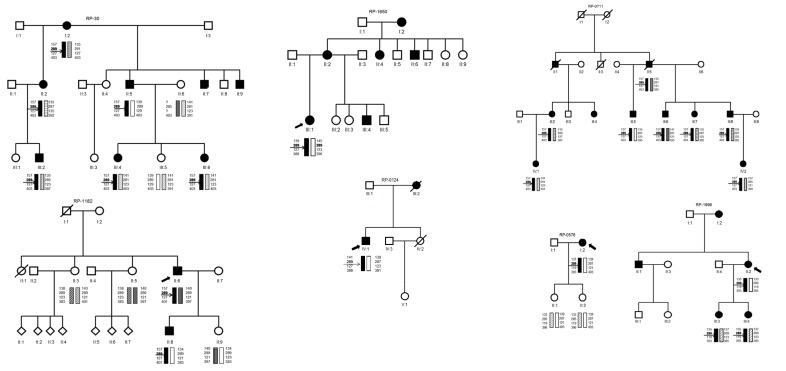
Pedigrees and Haplotype analysis of adRP families with p.Gly56Arg mutation in NR2E3.Haplotype analysis: → marks the NR2E3 gene position. The NR2E3 extragenic polymorphic markers used are D15S967, D15S1050, D15S204 and D15S188.